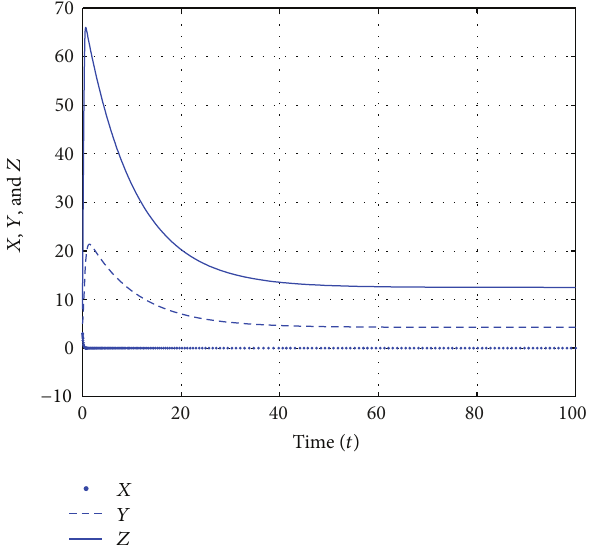
Figure 2: Time series plot of 𝑋 , 𝑌 , and 𝑍 for nonzero exogenous input ( 𝛾 = 1.25 ) and ℎ𝑝𝑞 < 𝛾 with 𝑋(0) = 3 , 𝑌(0) = 5 , and 𝑍(0) = 8 ; parameter values are given in Table 2.